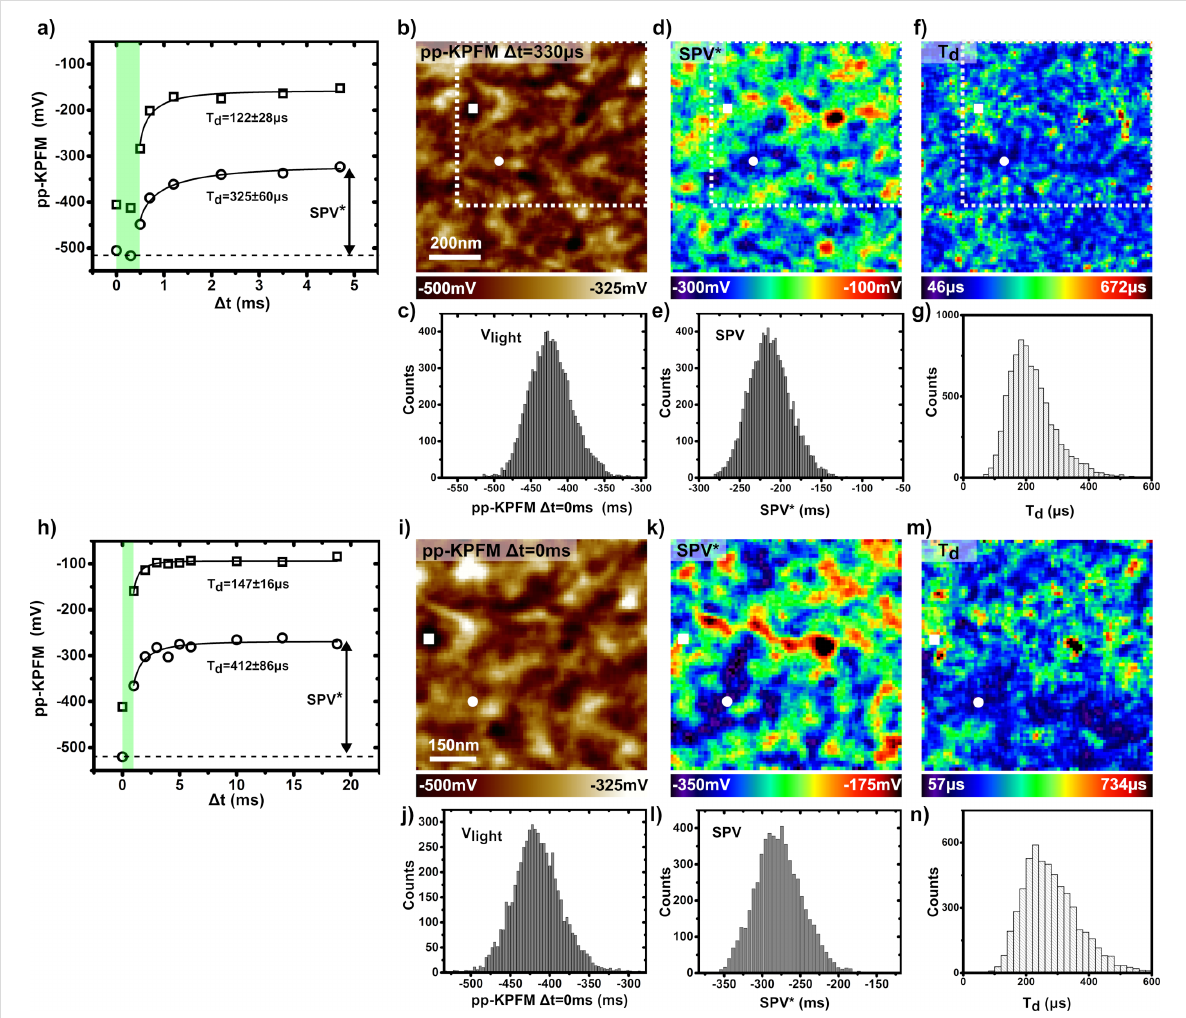
Figure 9: pp-KPFM spectroscopic imaging of the PTB7:PC 71 BM blend in data-cube mode. P opt = 18.5 mW ∙ cm − 2 (pulse peak power). (a–g) Data were acquired on a 90 × 90 grid using a first pump–probe sequence with pump pulses of 500 µs repeated at 200 Hz, a probe-time window of 200 µs, a data acquisition delay of 2 s and an integration time of 1 s. (h–n) Data were acquired on a 75 × 75 grid using the second pump–probe sequence with pump pulses of 1 ms repeated at 50 Hz, a probe-time window of 1 ms, a data acquisition delay of 2 s and an integration time of 1 s. (a, h) Spectroscopic curves acquired applying the first (a) and the second (h) sequence at two distinct points on the surface, which are highlighted by a circle and a square in the images. (b, d, f) Reconstructed images (first sequence) (b) of the pp-KPFM potential for a delay of 330 µs, (d) of the pseudo photovoltage SPV* (see text) and (f) of the SPV decay-time constant. (c, e, g) Corresponding histograms. (i, k, m) Reconstructed images (second sequence) (i) of the pp-KPFM potential for a delay of 0 ms, (k) of the pseudo photovoltage SPV* and (m) of the SPV decay-time constant. (j, l, n) Corresponding histograms. To reduce the fit error, all curves were adjusted by using a fixed stretch exponent β of